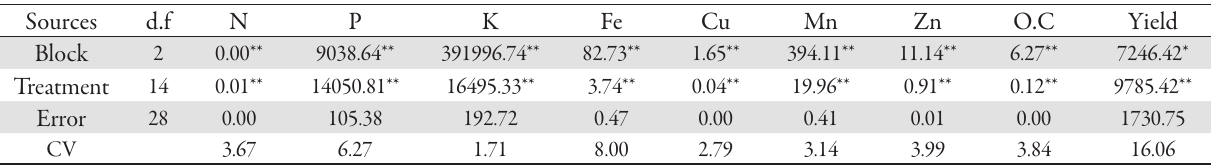
Tab. 4. Analysis of variance on micro and macro elements, organic carbon and seed yield affected by different nutrition management (the values in the table are mean